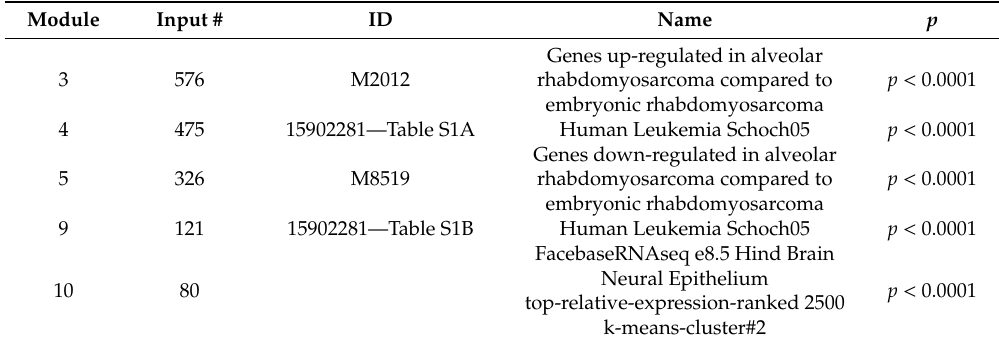
Table 3. Top results of ToppGene co-expression analysis for the 5 largest co-expressed modules identified by consensus lmQCM analysis (See Table S3 for more detailed table).